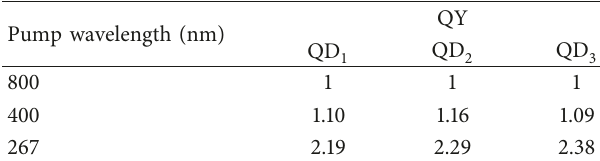
QD . 8 1 ) (cid:29) 1 (